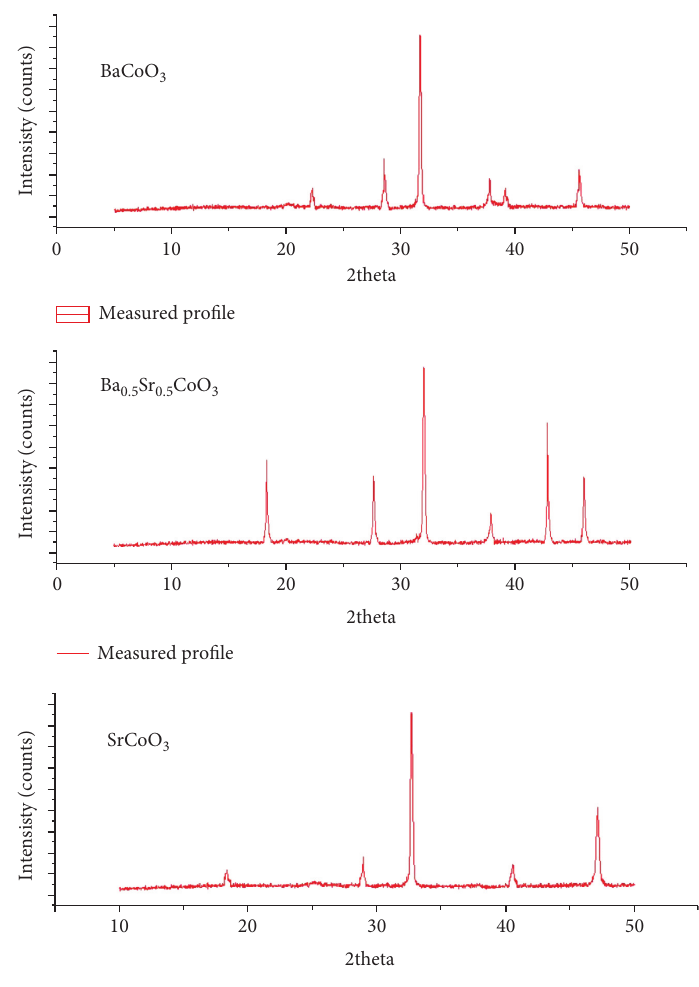
Figure 5: XRD Peaks of synthesised